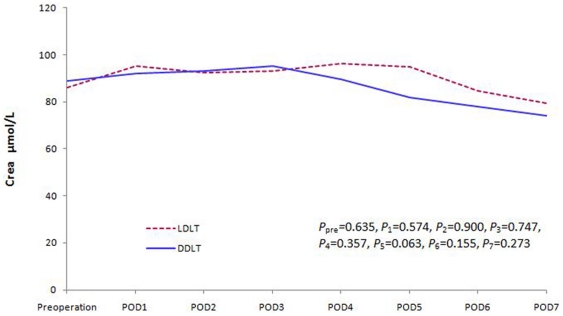
Creatinine level changes during the first postoperative week (P
pre
 = 0.635, P
1 = 0.574, P
2 = 0.900, P
3 = 0.747, P
4 = 0.357, P
5 = 0.063, P
6 = 0.155, P
7 = 0.273).